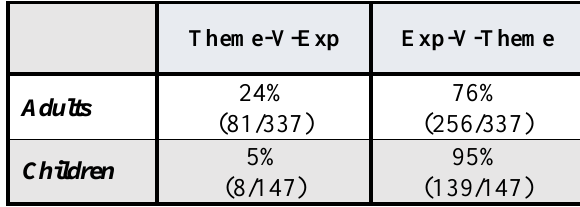
Table 2. Corpus study results by age group and relevant word